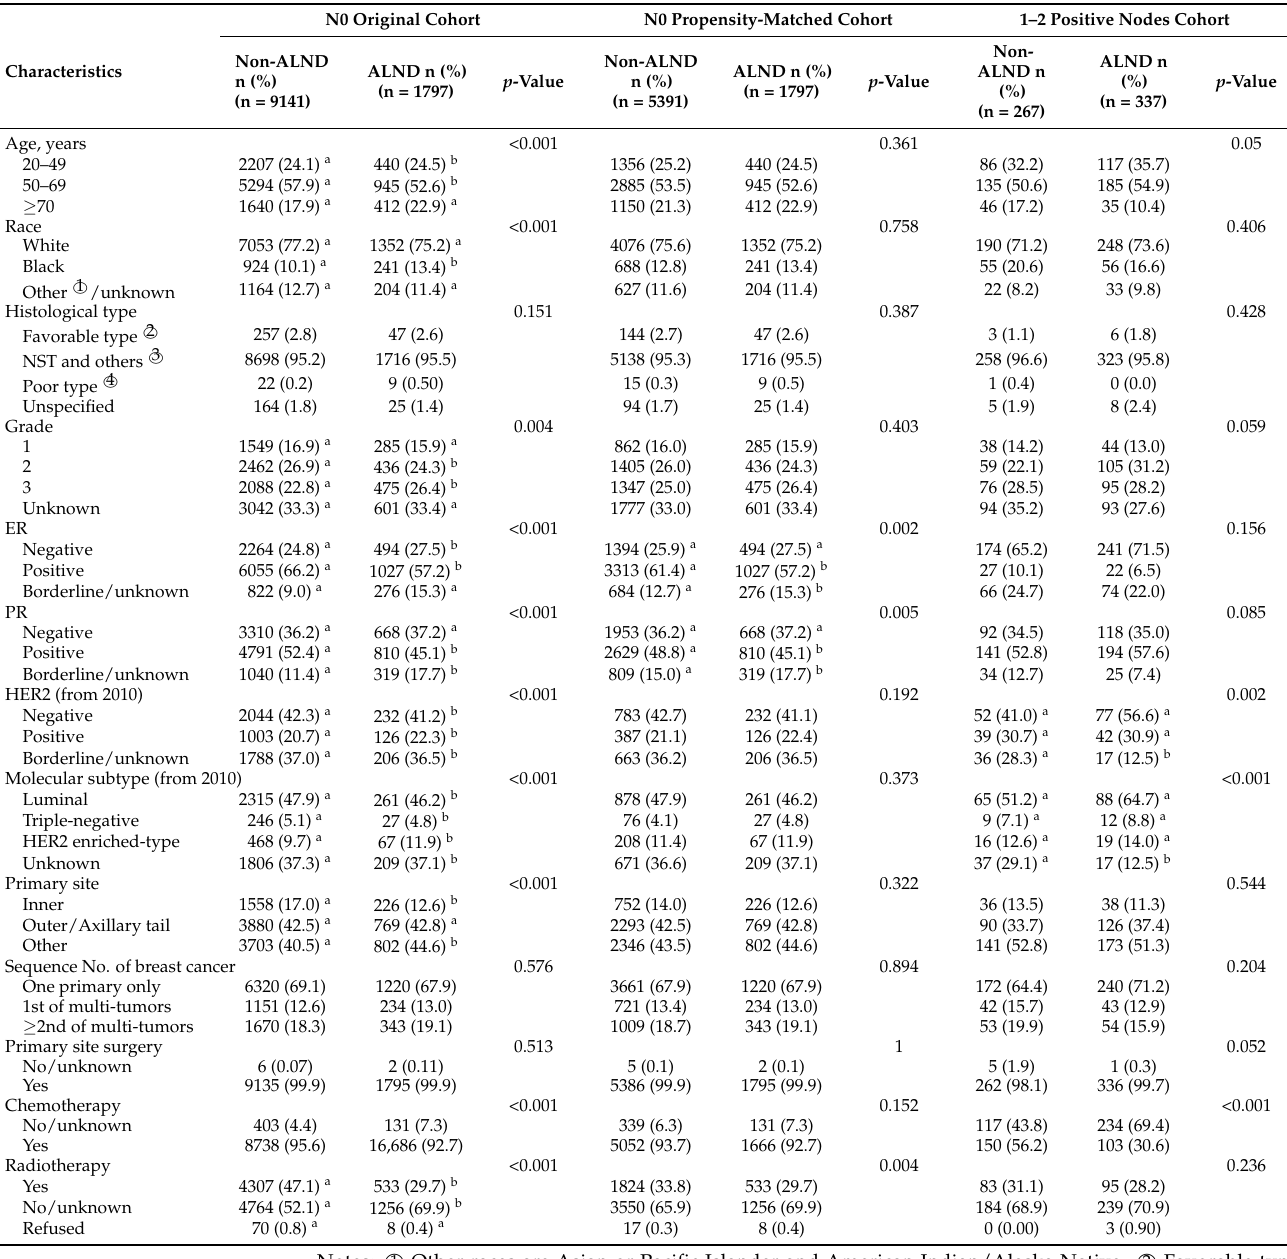
Table 3. Baseline characteristics between non-ALND and ALND subgroups in cohort with N0 and 1–2 positive